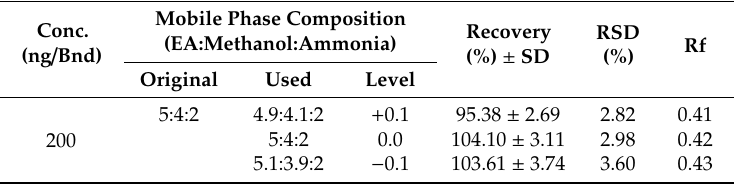
Table 3. Robustness of HPTLC method at the concentration of 200 ng / band ( n = 6).